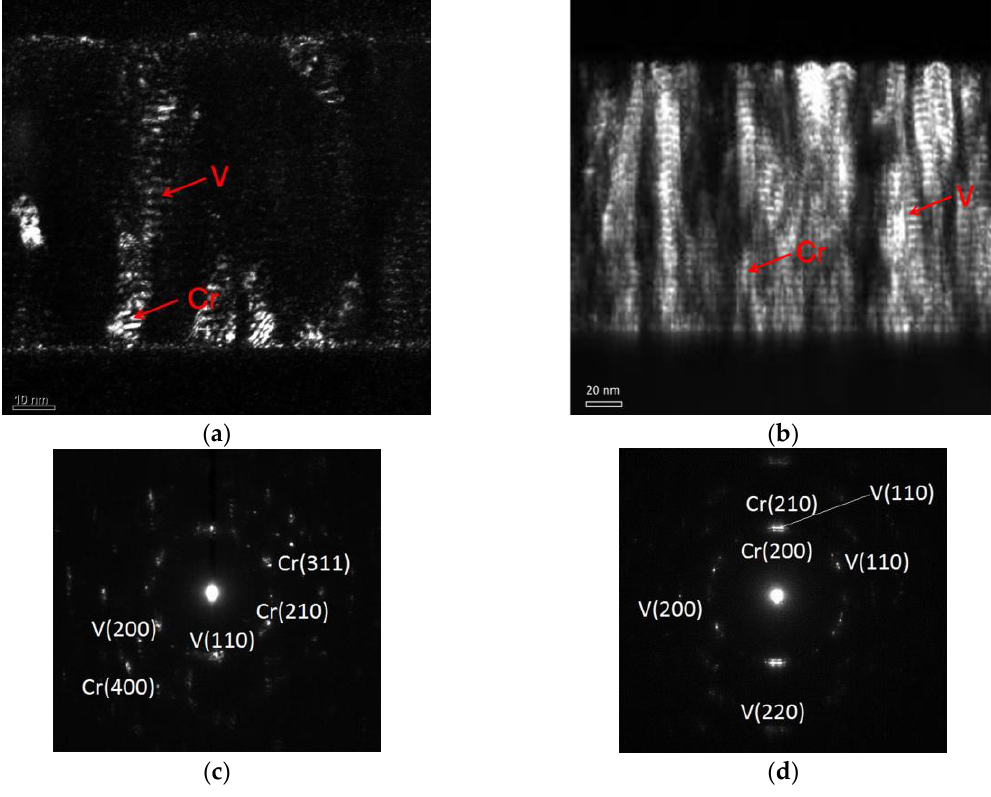
Figure 6. Dark field TEM images of Cr/V multilayer samples with vanadium layers thickness ( a ) d V = 1.2 nm and ( b ) d V = 4.0 nm, and SAED patterns of the same samples with ( c ) d V = 1.2 nm and ( d ) d V = 4.0 nm.